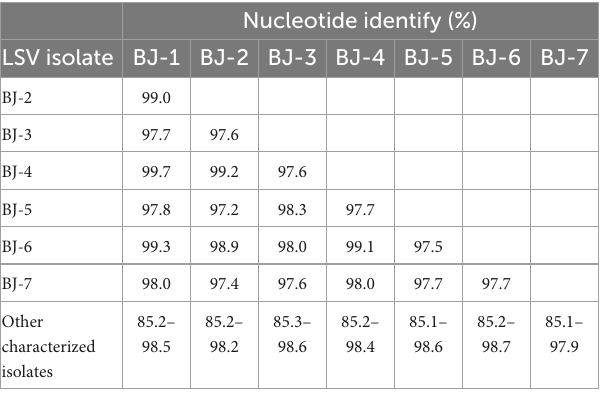
TABLE 7 Pairwise nucleotide sequence identity of genomic RNA of each LSV isolate and the identity of each LSV isolate with all other characterized isolates.